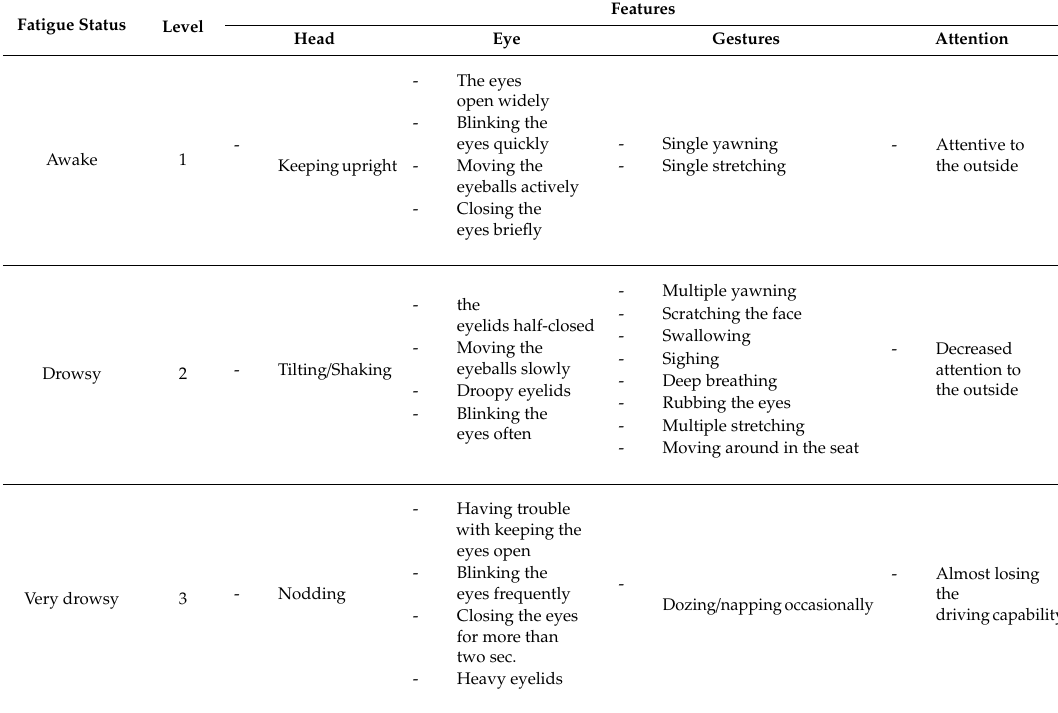
Table 1. Criteria for driver fatigue status evaluation (adapted from Li et al.